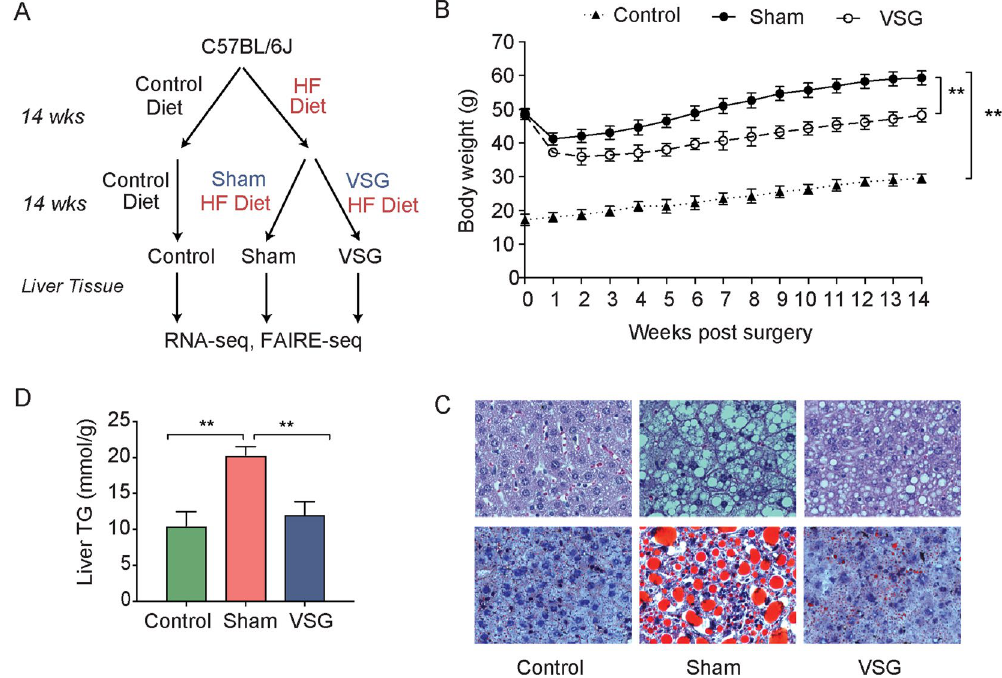
Figure 1. Characteristics of C57BL/6J mice after vertical sleeve gastrectomy (VSG). ( A ) Scheme for mice feeding and surgery for Control, Sham, and VSG group. ( B ) Body weight (grams) over the course of the 14 weeks for Control, Sham, and VSG group. Error bars represent standard error of the mean from 9 to 12 mice in each group. ( ** Indicates p < 0.01) Sham and VSG weights are from Ding, L. et al . 12 . ( C ) Hematoxylin and eosin (top) and Oil Red O (bottom) staining from livers of Control, Sham and VSG mice. ( D ) Liver triglyceride (milligrams/g) levels of Control, Sham, and VSG mice. Values are mean ± S.D. (n = 5 per group, ** Indicates p <